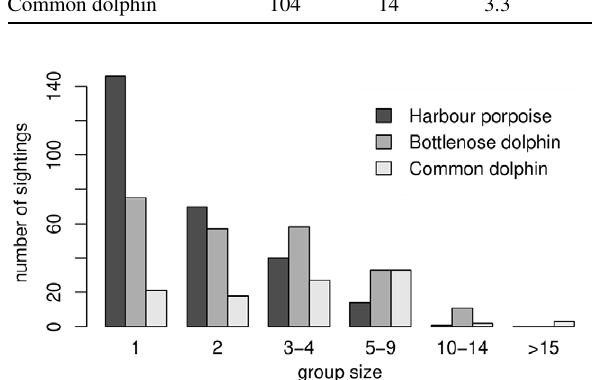
Fig. 3. – Group size of three cetacean species in the study area ob- served from January 2018 to May 2020.